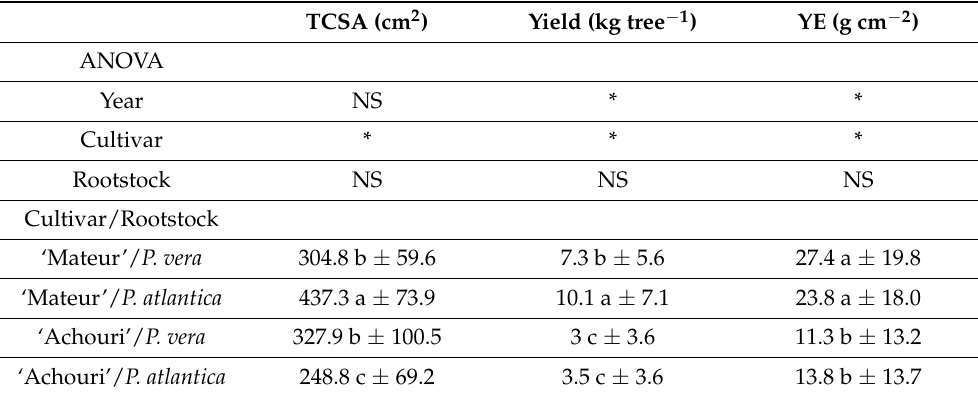
Table 1. Trunk-cross-sectional area (TCSA), average tree yield and yield efficiency (YE). Values ( n = 5 to 8) followed by the same letter, within the same column, were not significantly different; NS: not significant; * Significant ( p ≤